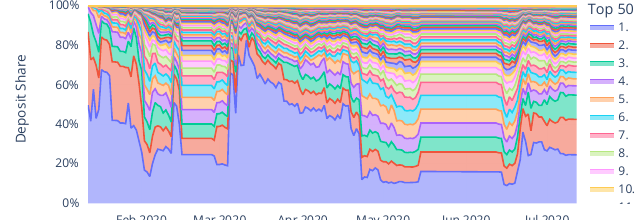
Figure 3 . Deposit shares of the top 50 USDC depositors on Aave between January and June 2020 (relative to each other) [15] Note: Deposit shares and rank (top 50) are calculated using the 50 largest depositors at specific points in time. This means that the largest depositor on a given day may be a different user than the largest depositor on another